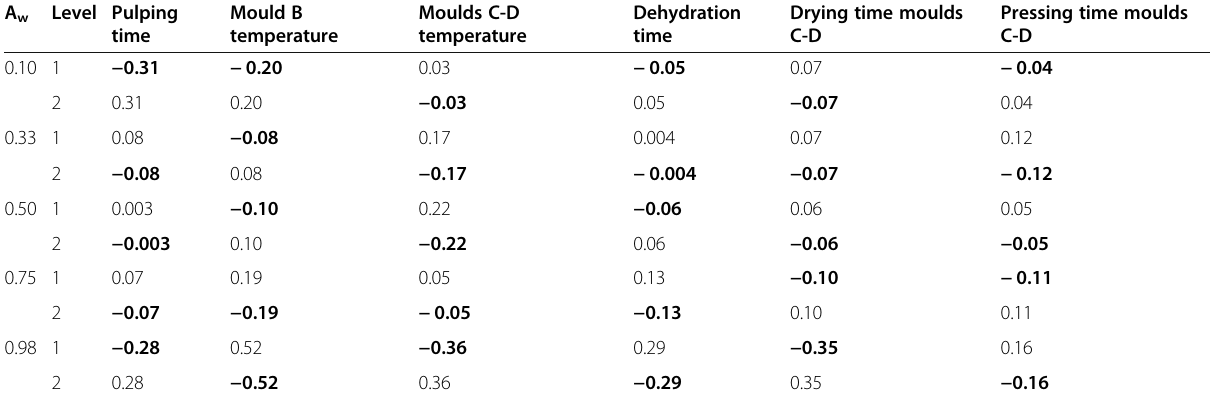
Table 4 Resulting effect for each factor tested on water uptake of samples after sorption A w Level Pulping